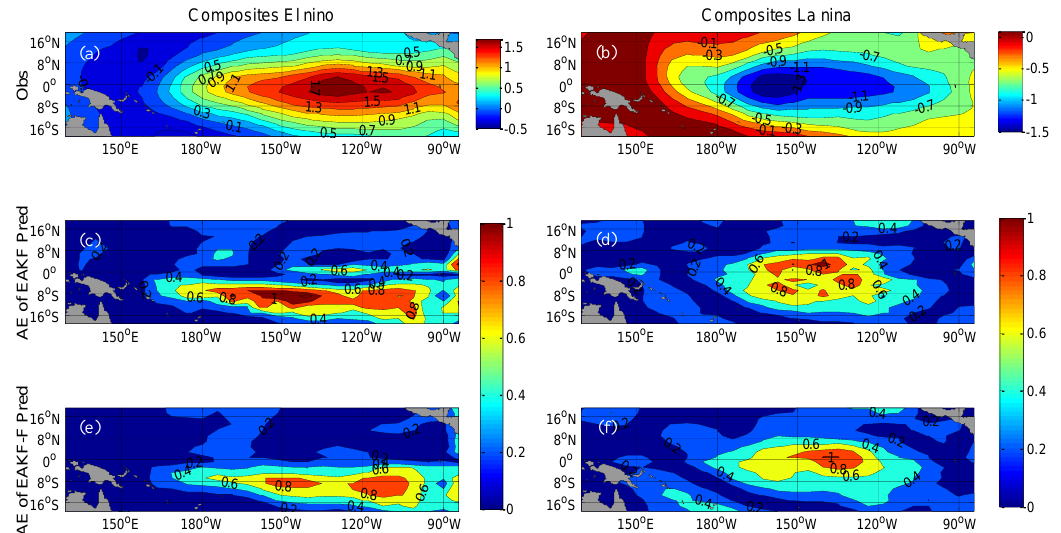
Figure 11. Composite ( a ) El Niño and ( b ) La Niña calculated from observations. AEs of the predicted composite ( c ) El Niño and ( d ) La Niña using EAKF-Pred with a lead time of 6 months. AEs of the predicted composite ( e ) El Niño and ( f ) La Niña using EAKF_F-Pred with a lead time of 6 months.